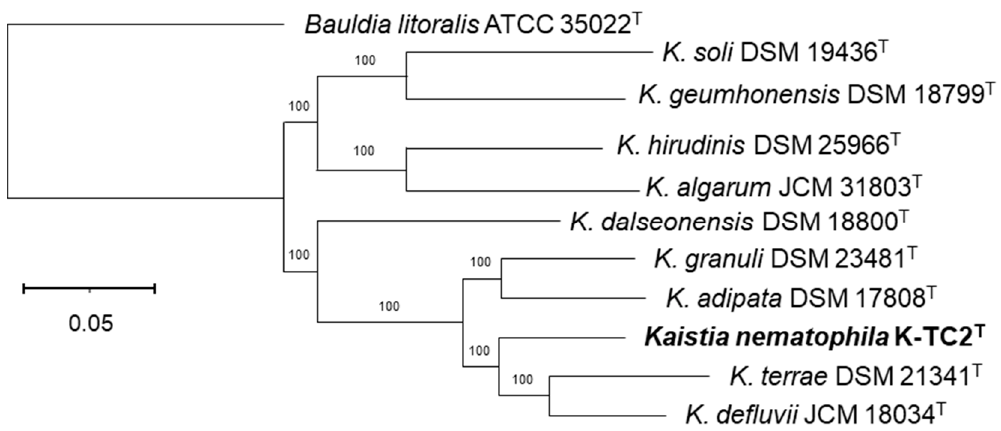
Figure 4. Phylogeny based on core genome sequences of all the species of the genus Kaistia. 543369 nucleotide positions (508 core genes) were used in the analyses. Numbers at the nodes represent SH-like branch supports. Phylogenomic trees were built using FastTree 2.1.10 based on the Generalized Time Reversible Model (GTR) [61]. Accession numbers of the sequences used in the analyses are shown in Table S1. Bold indicates a novel taxonomic proposal. Table 4. Pairwise comparison of digital DNA-DNA Hybridization (dDDH) scores (%) of all the species of the genus Kaistia . Accession numbers of the sequences used in the analyses are shown in Table S1. Colors indicate the degree of relatedness between bacterial species.